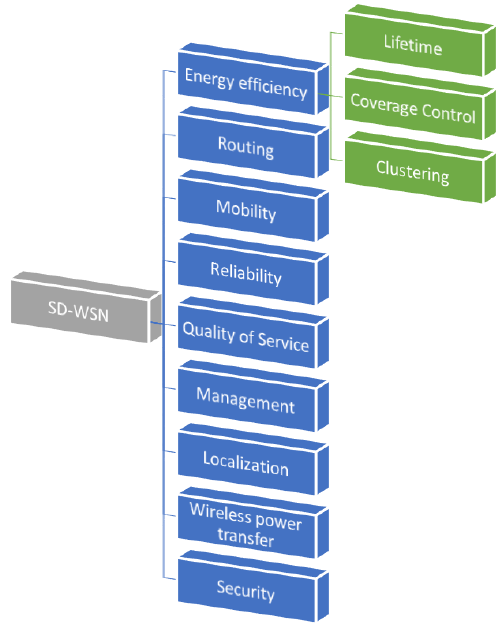
Figure 1. Advances in software-defined wireless sensor